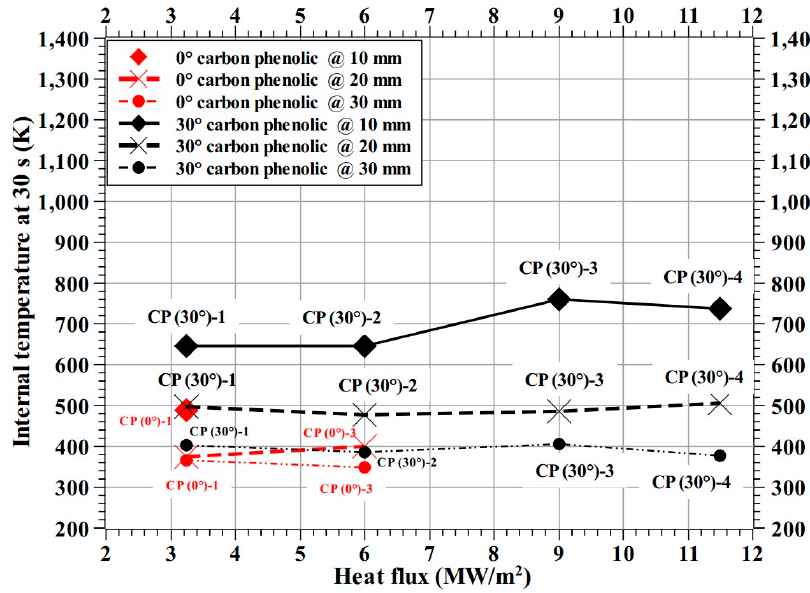
Figure 25. Internal temperature at 30 s (carbon phenolic 0° and 30°).